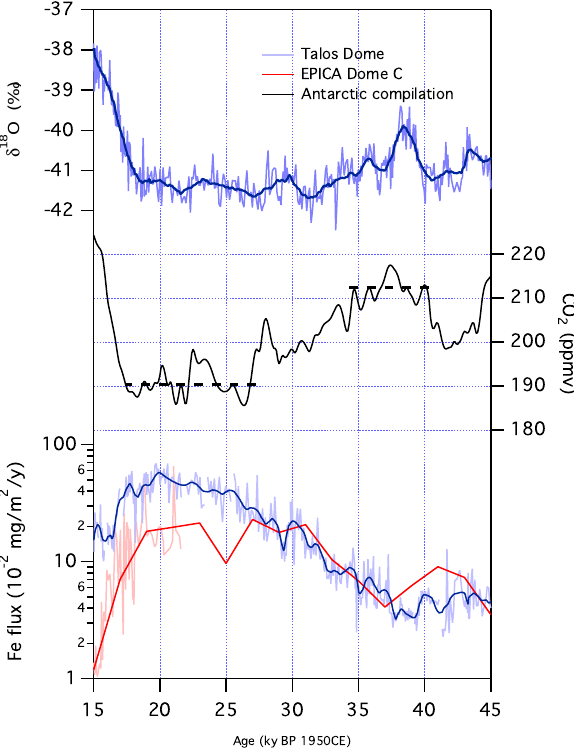
Fig. 4. Comparison of LGM Fe fluxes and late glacial drawdown of CO 2 . TALDICE δ 18 O paleotemperature values are from (Stenni et al., 2011). CO 2 concentrations were compiled from various Antarc- tic ice cores (L¨uthi et al., 2008; Schilt et al., 2010) while Fe fluxes are shown for TD (this work) and EDC (Wolff et al., 2006; Gaspari et al., 2006) ice